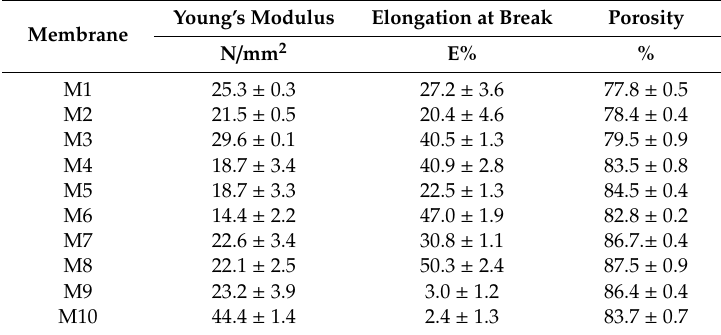
Table 5. Mechanical properties and porosity of the prepared